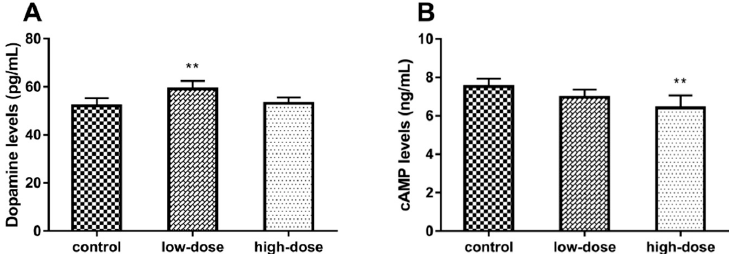
Figure 3. Effects of atrazine ATR exposure on dopamine and cAMP levels, as measured with an enzyme-linked immunosorbent assay. ( A ) Hippocampal dopamine levels in the control, low-dose, and high-dose groups (52.125 ± 3.386, 59.083 ± 3.585, and 53.151 ± 2.613 pg/mL, respectively). ( B ) Hippocampal cAMP levels in the control, low-dose, and high-dose groups (7.532 ± 0.436, 6.974 ± 0.439, and 6.410 ± 0.712 ng/mL, respectively). Each column represents the mean ± S.E.M, six rats per group, ** p < 0.01 vs. the control